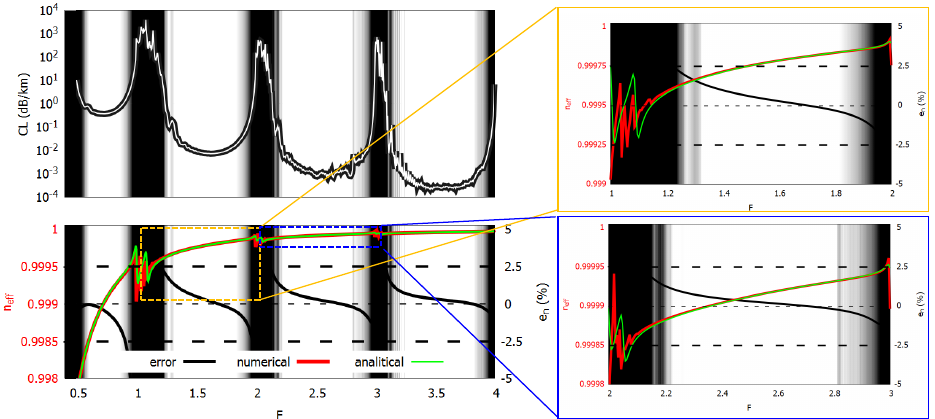
Figure 3. Left side: Confinement loss ( top ) and effective index ( bottom ) of fiber F#1. Dark regions correspond to high-loss regions. For the effective index, solid green, red, and black curves show numerical and analytical result, and relative error, respectively. Right side: detail on the effective index in the normalized frequency ranges [1:2] ( top ), and [2:3] ( bottom ).